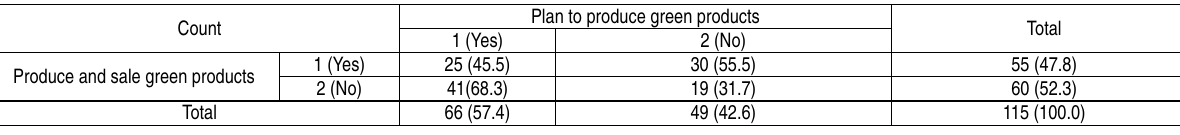
Table 2. Cross tabulation: relation between plan to produce green products with actual production and sale of green products